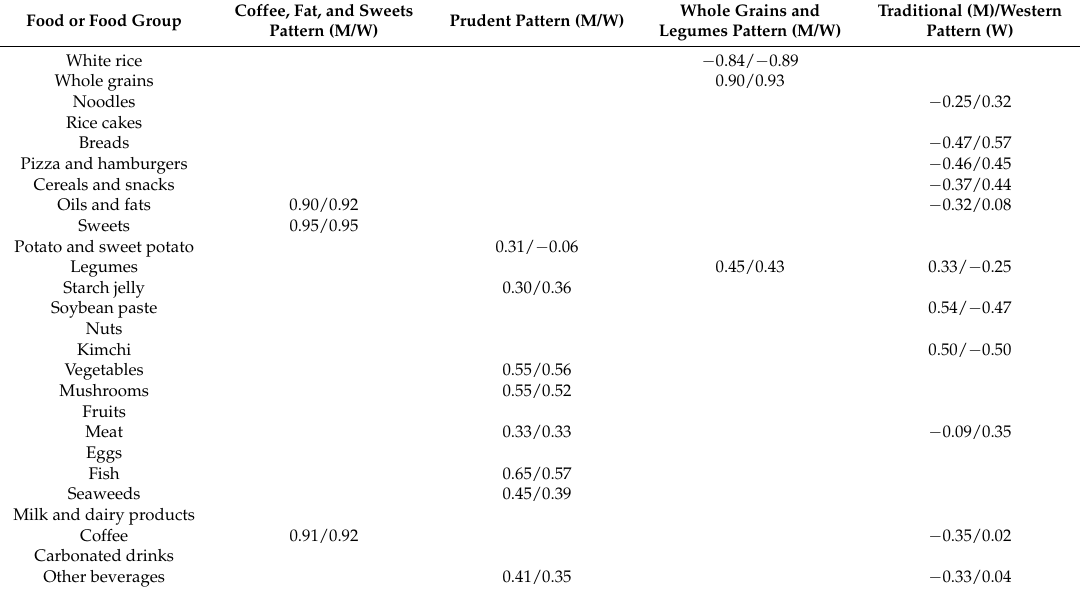
Table 1. Factor loading matrix for major dietary patterns of Korean adults by gender 1 . Food or Food